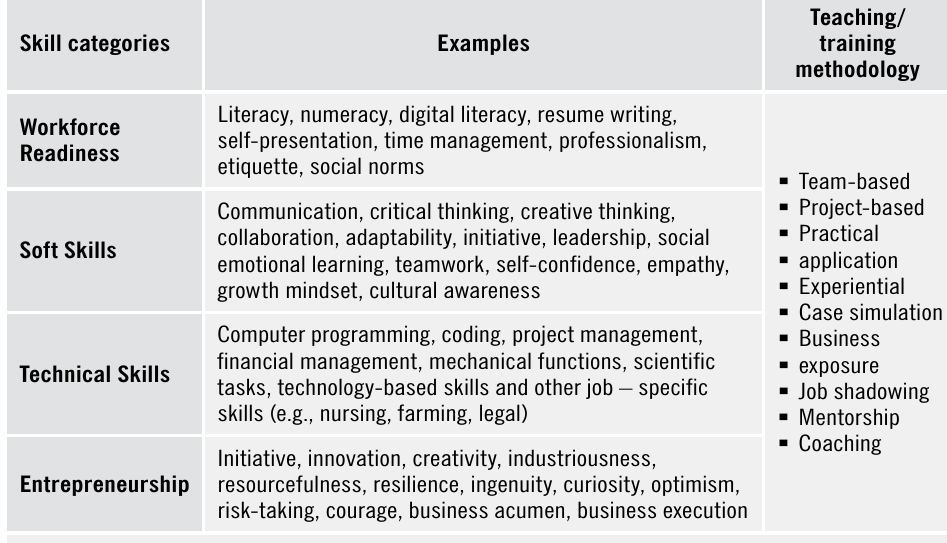
Table 2. Skills required for 4IR by